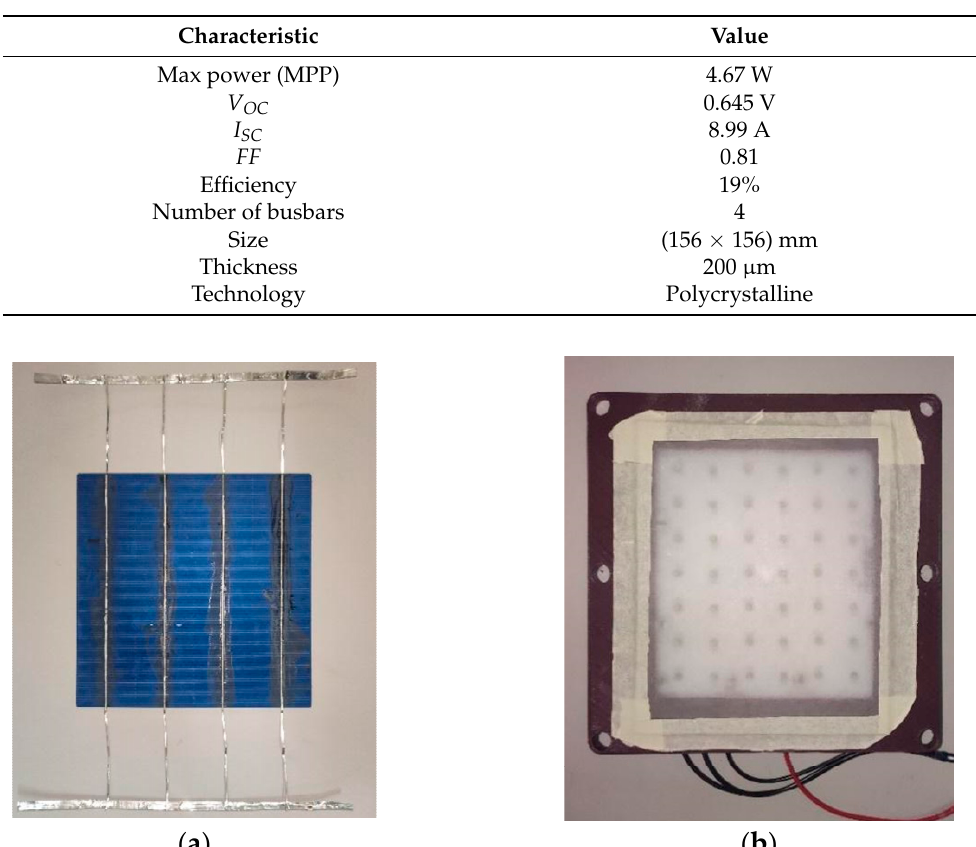
Table 1. Technical characteristics of the PV cells used at nominal conditions (1000 W/m 2 of solar spectrum and 25 ◦ C).